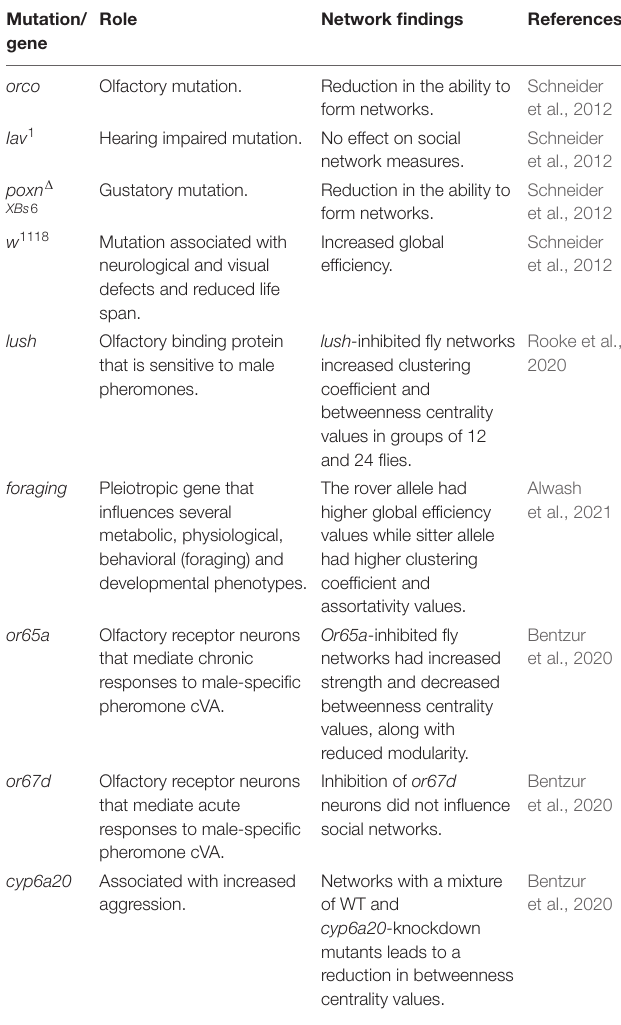
TABLE 5 | Summary of various genes and sensory manipulations studied in Drosophila social network